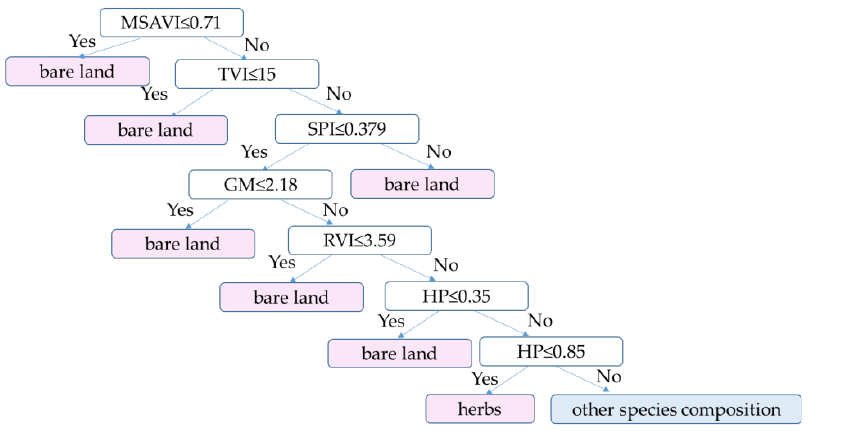
Figure 11. The decision tree classifier for classifying bare land, herbs, and other species compositions.